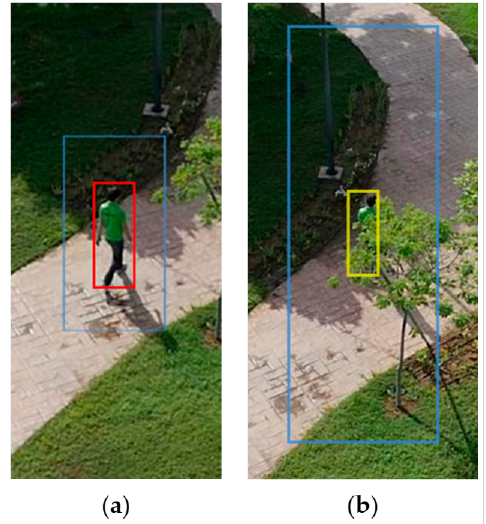
Figure 11. ( a ) The searching window extends 72 px from the object when unobscured; ( b ) object occlusion. The yellow box represents the object label of the last mark which was detected successfully; the blue box represents the size of searching windows increases since the PCGF doesn’t detect the